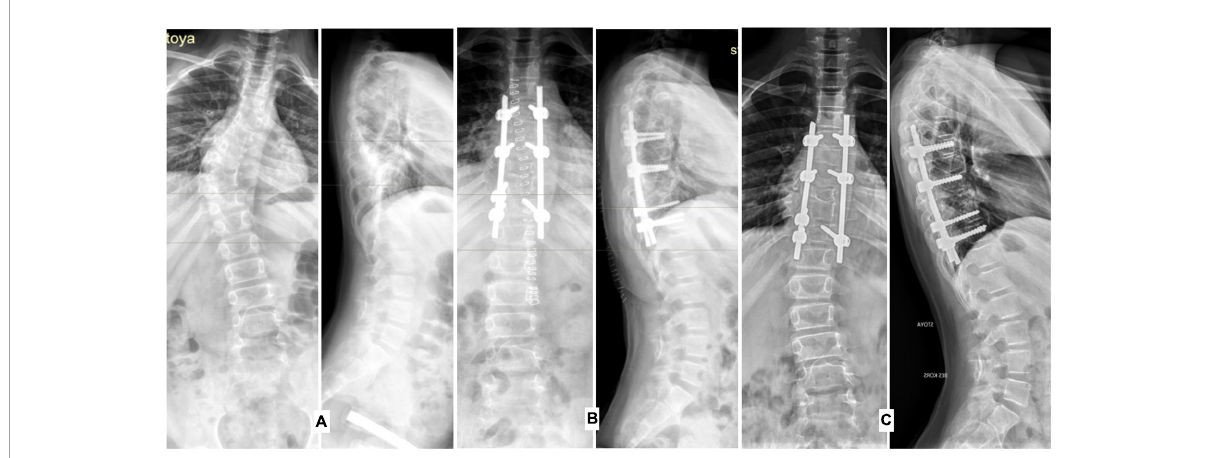
FIGURE2 Radiographs of the spine in frontal and lateral projections, patient operated at the age of 9 years 6 months: (A) before surgical treatment, (B) on the 7th day after surgical treatment, (C) 1.5 years after correction of congenital deformity spine (dysplastic deformity of the spine below the zone of metal